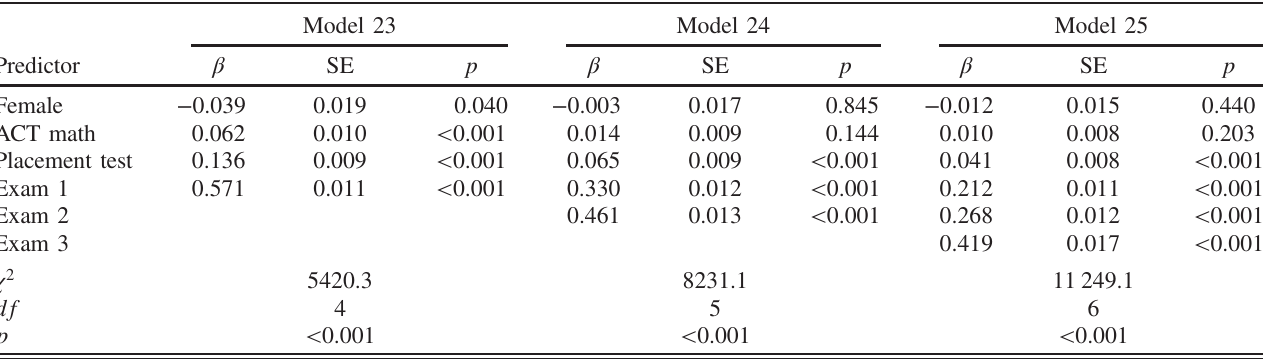
XVII. Multiple linear regression models of physics 1 final exam scores on gender, ACT math scores, physics placement test scores, and course exam scores. Female is coded as 1 and male is coded as 0 for the gender variable. Continuous variables are standardized. Only the Wald test results are reported because the models violated the multiple linear regression assumption of homogeneity of variances. The error bars and p -values were adjusted to account for this violation.